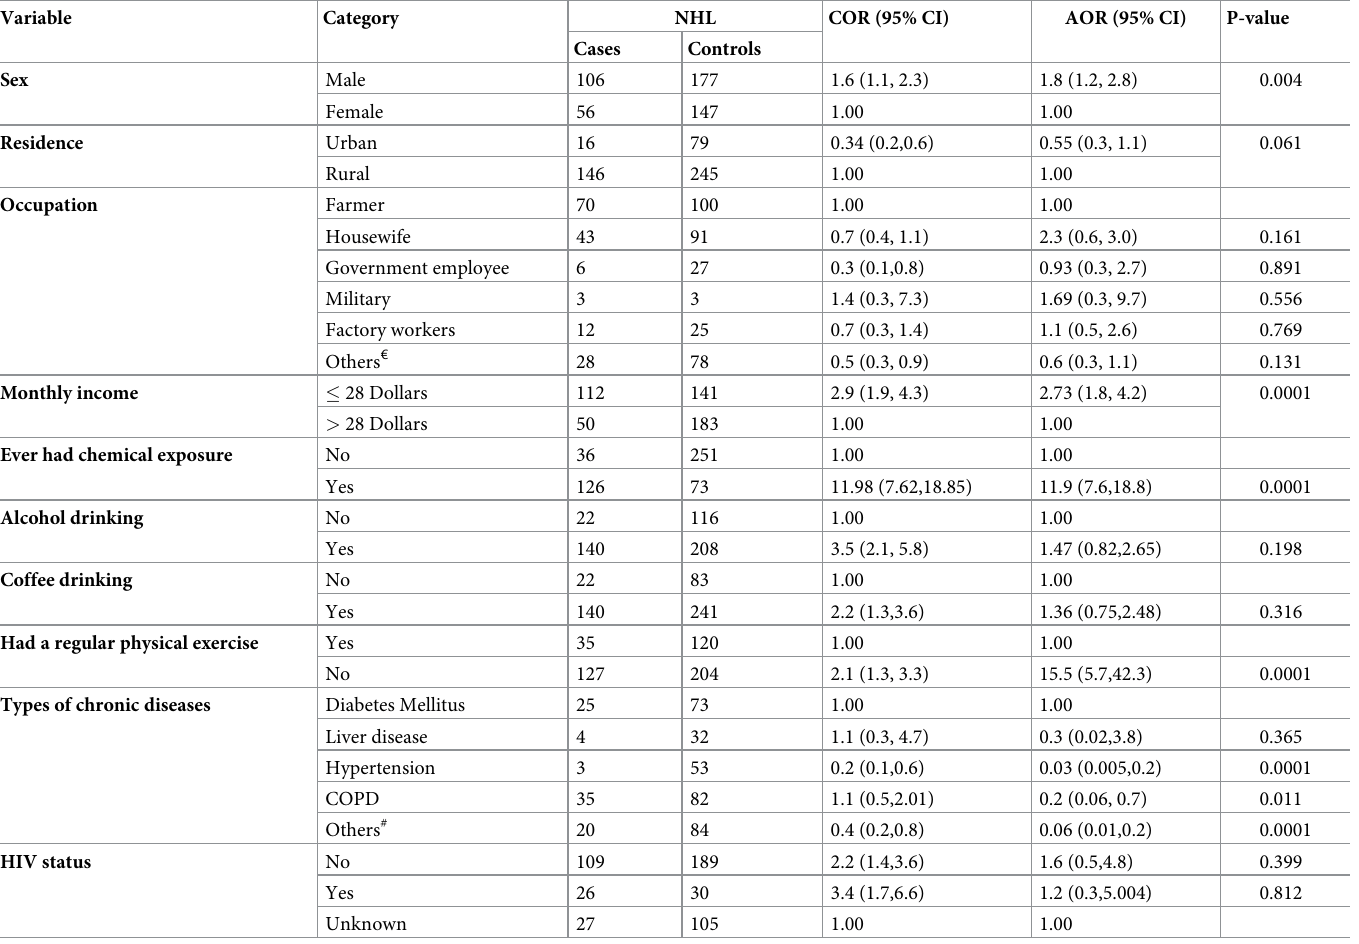
Table 5. Simple logistic regression on determinants of NHL at Felegehiwot specialized hospital, northwest Ethiopia, 2019. Variable